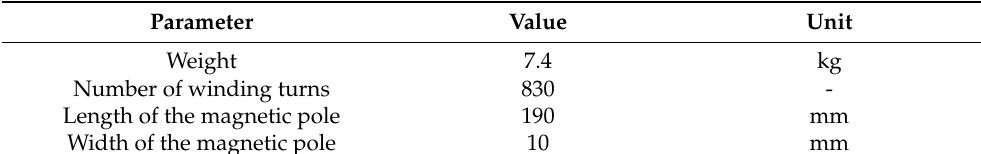
Table 1. Parameters of the electromagnet.